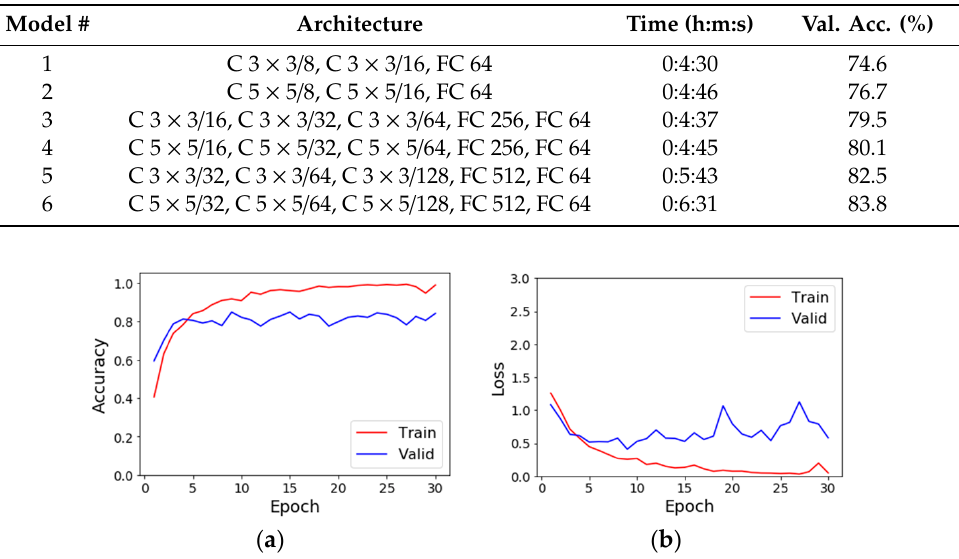
Table 3. Experimental results with six architectures. The convolutional layers’ parameters are denoted as “C kernel size / number of kernels”. The fully connected layers are denoted as “FC number of hidden units”. Epoch = 30, learning rate = 1 × 10 − 4 .